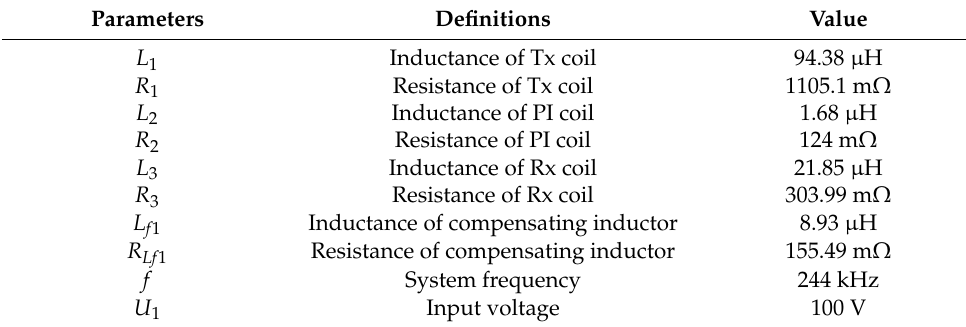
Table 3. The parameters of the proposed WPT system.